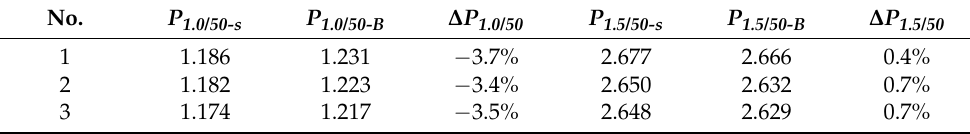
Table 2. The evaluation matrix of the three optimized parameter combinations. No. P